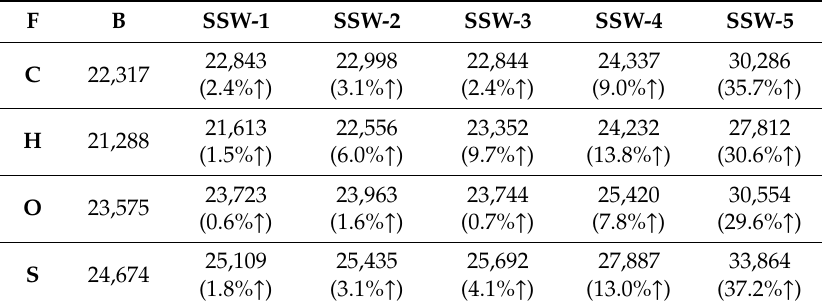
Table A4. Travel distance from residents in St. Anthony Parish to destinations.